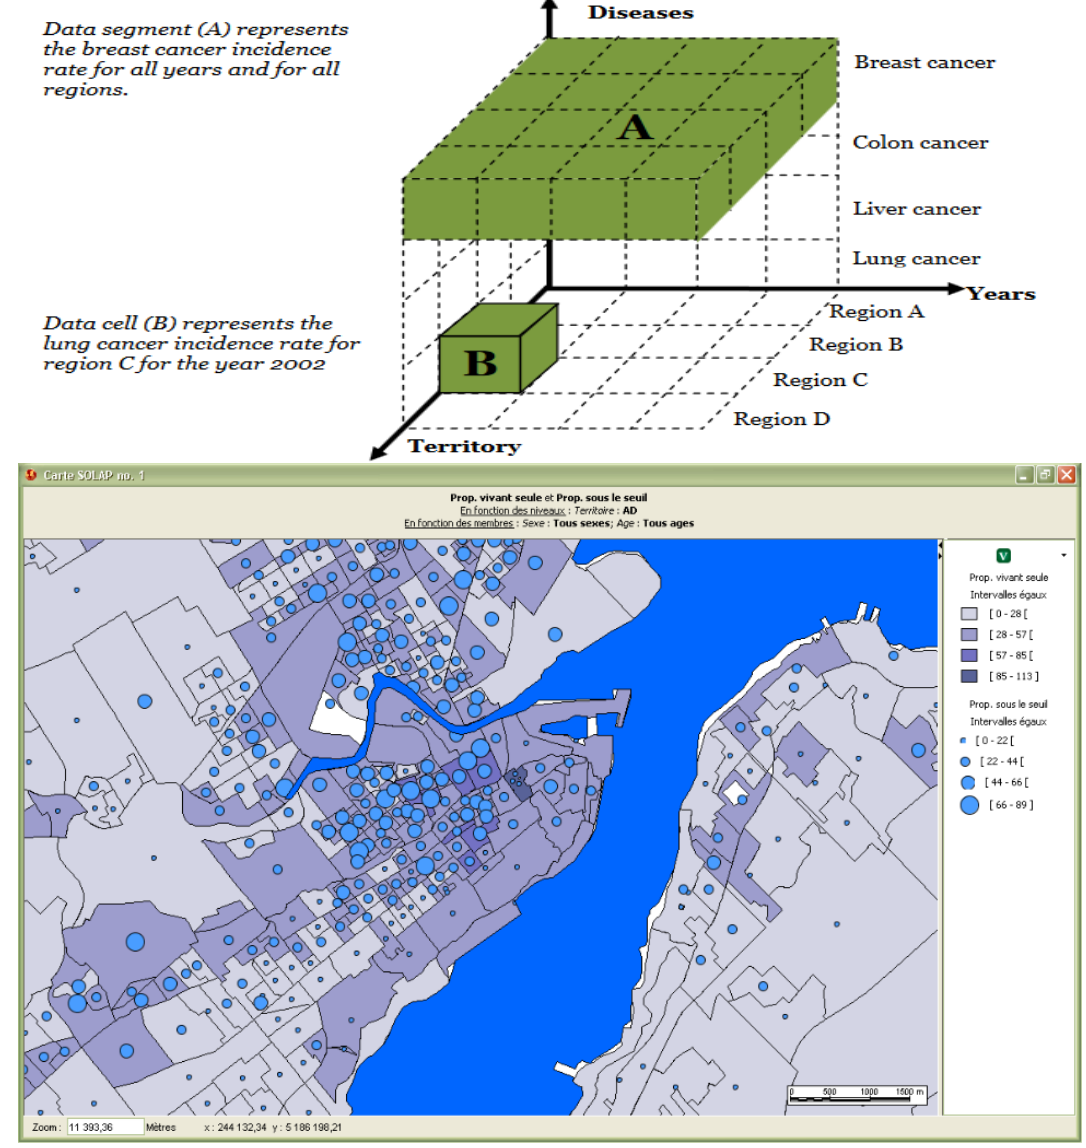
Figure 2. ( Top ) Multidimensional cube: two examples of incidence rates by territory, time, and diseases. ( bottom ) Combining facts: people living alone (color map), and people with low income (symbols).